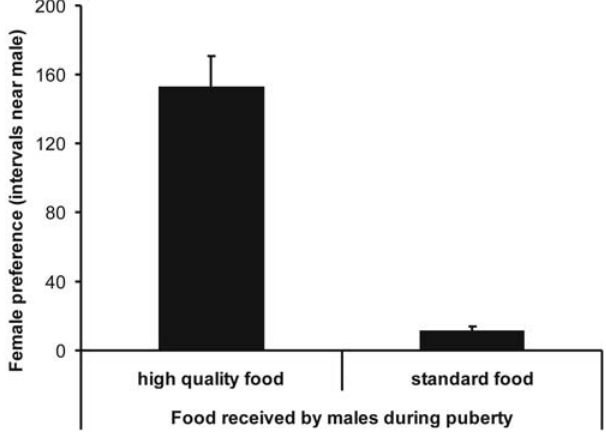
conditions from day 35 to day 60.